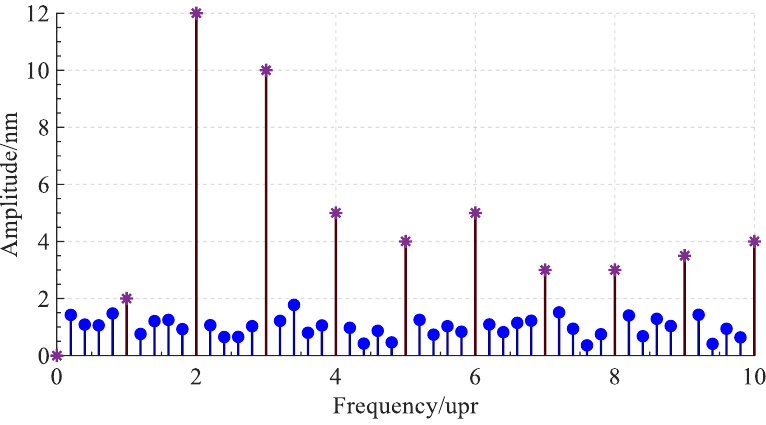
Figure 3. Frequency domain map of original data after Fourier transform.